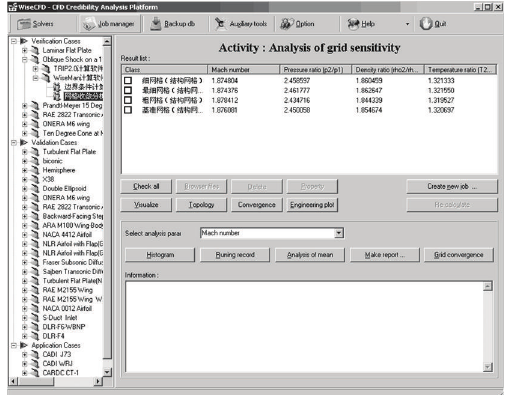
Figure 7: Graphic user interface (GUI) of the WiseCFD